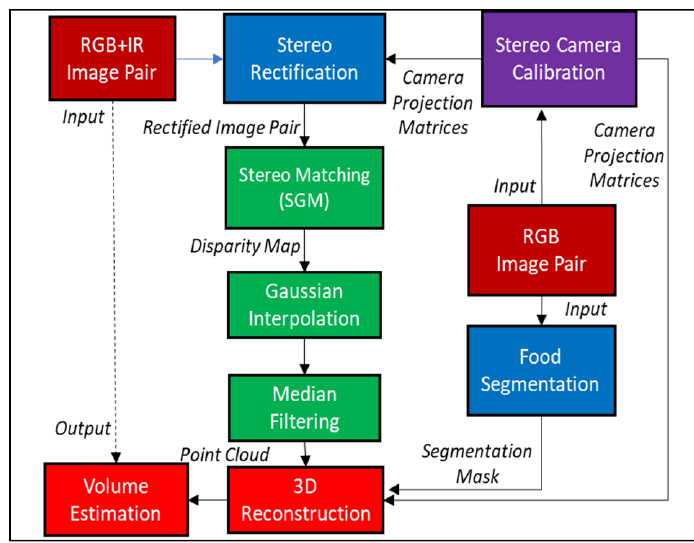
Figure 2. Flowchart of the proposed approach.